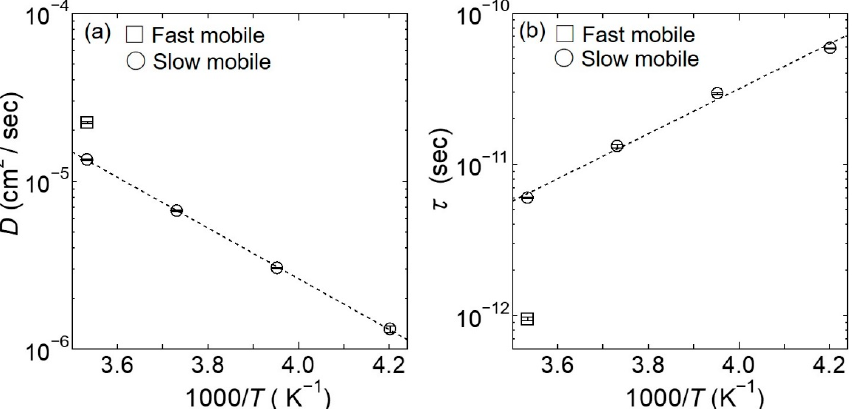
Figure 8. Arrhenius plots of ( a ) D and ( b ) τ for the slow mobile water at 238, 253, 268, and 283 K (depicted as circles), and for the fast mobile water at 283 K (depicted as squares), which were ob- tained as fitting parameters during analysis based on the jump-diffusion model for Γ slow and Γ fast . The black dotted lines in the plots of ( a ) D and ( b ) τ for the slow mobile water represent the results fitted by the Arrhenius Equation. The errors estimated from the fitting procedure are indicated by bars.